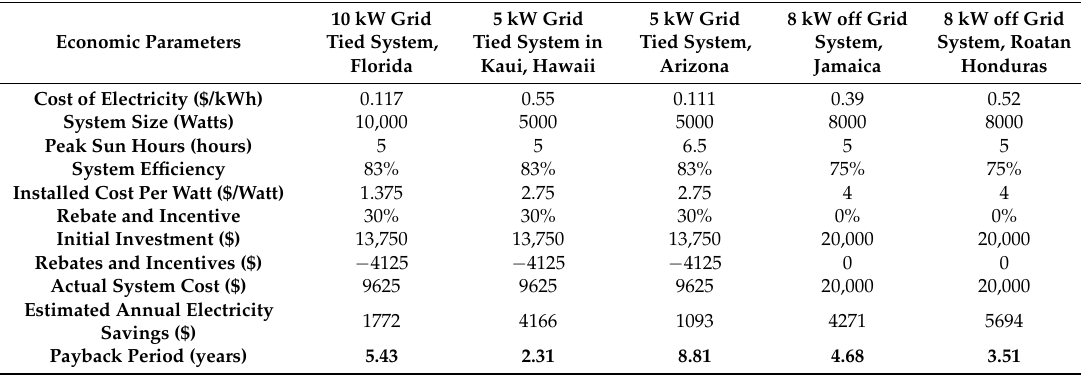
Table 1. The Payback Period of five Photovoltaics (PV) investments